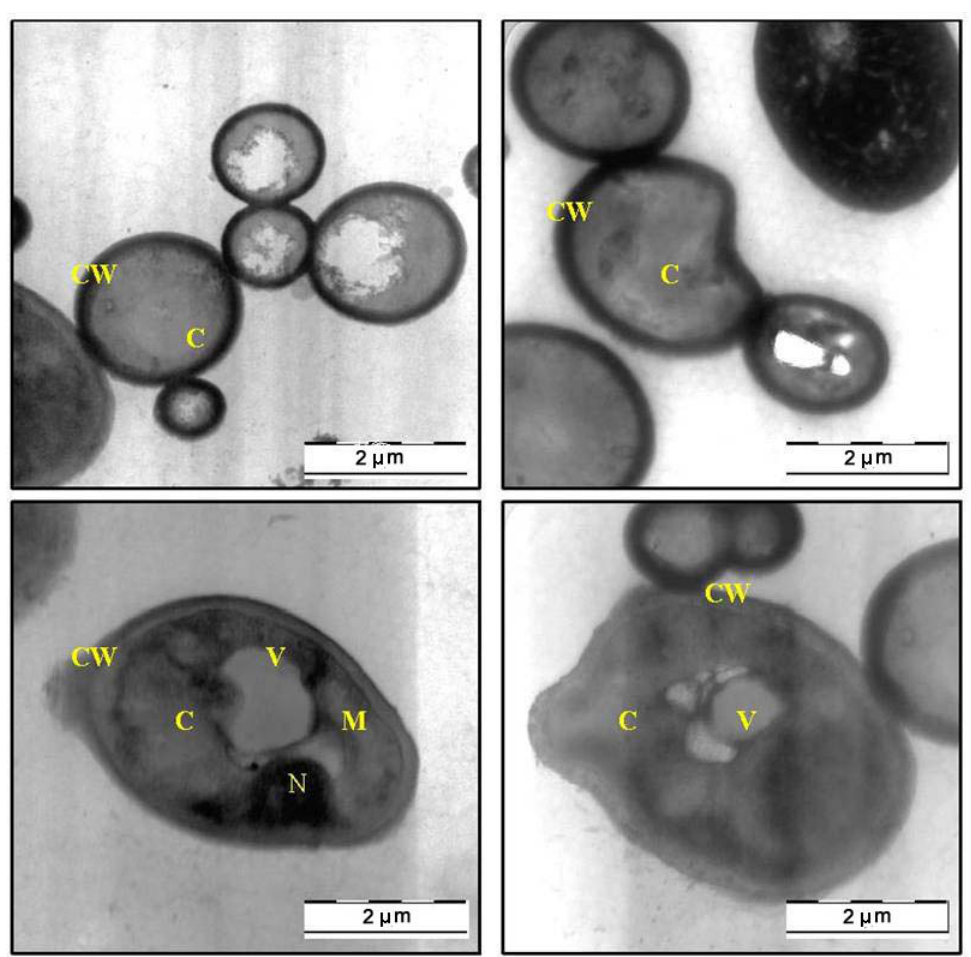
Figure 3. TEM micrograph of a cross-section of untreated cell of Candida albicans (C: Cytoplasm; CW: Cell Wall; M: Mitochondria; N: Nucleus; V: Vacuole).